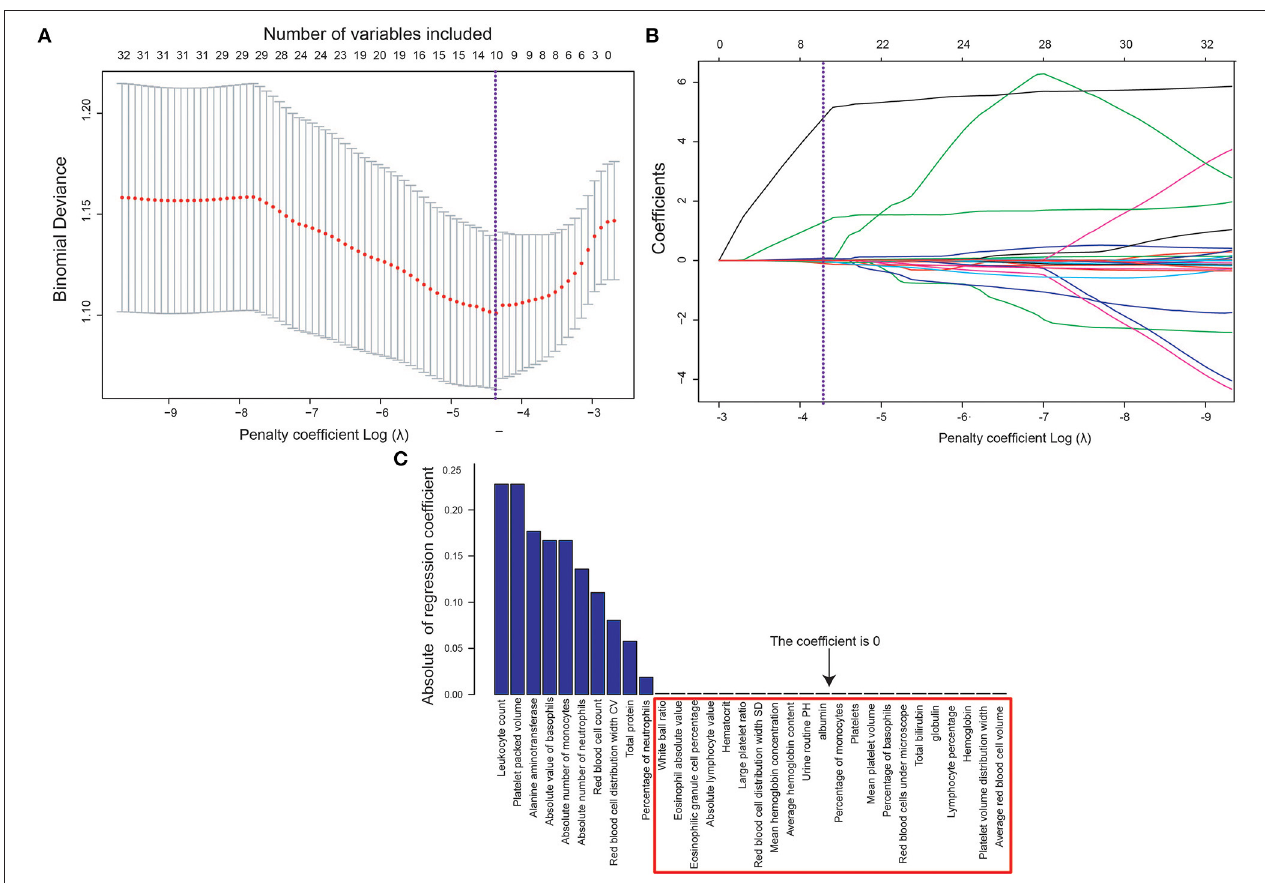
FIGURE 1 | (A) Tuning parameter ( λ ) selection in the Lasso model used tenfold cross-validation based on the minimum criteria. (B) Changes in 32 marker coefficients with the penalty parameter ( λ ). (C) 32 marker coefficients obtained according to the selected best penalty parameter ( λ ).